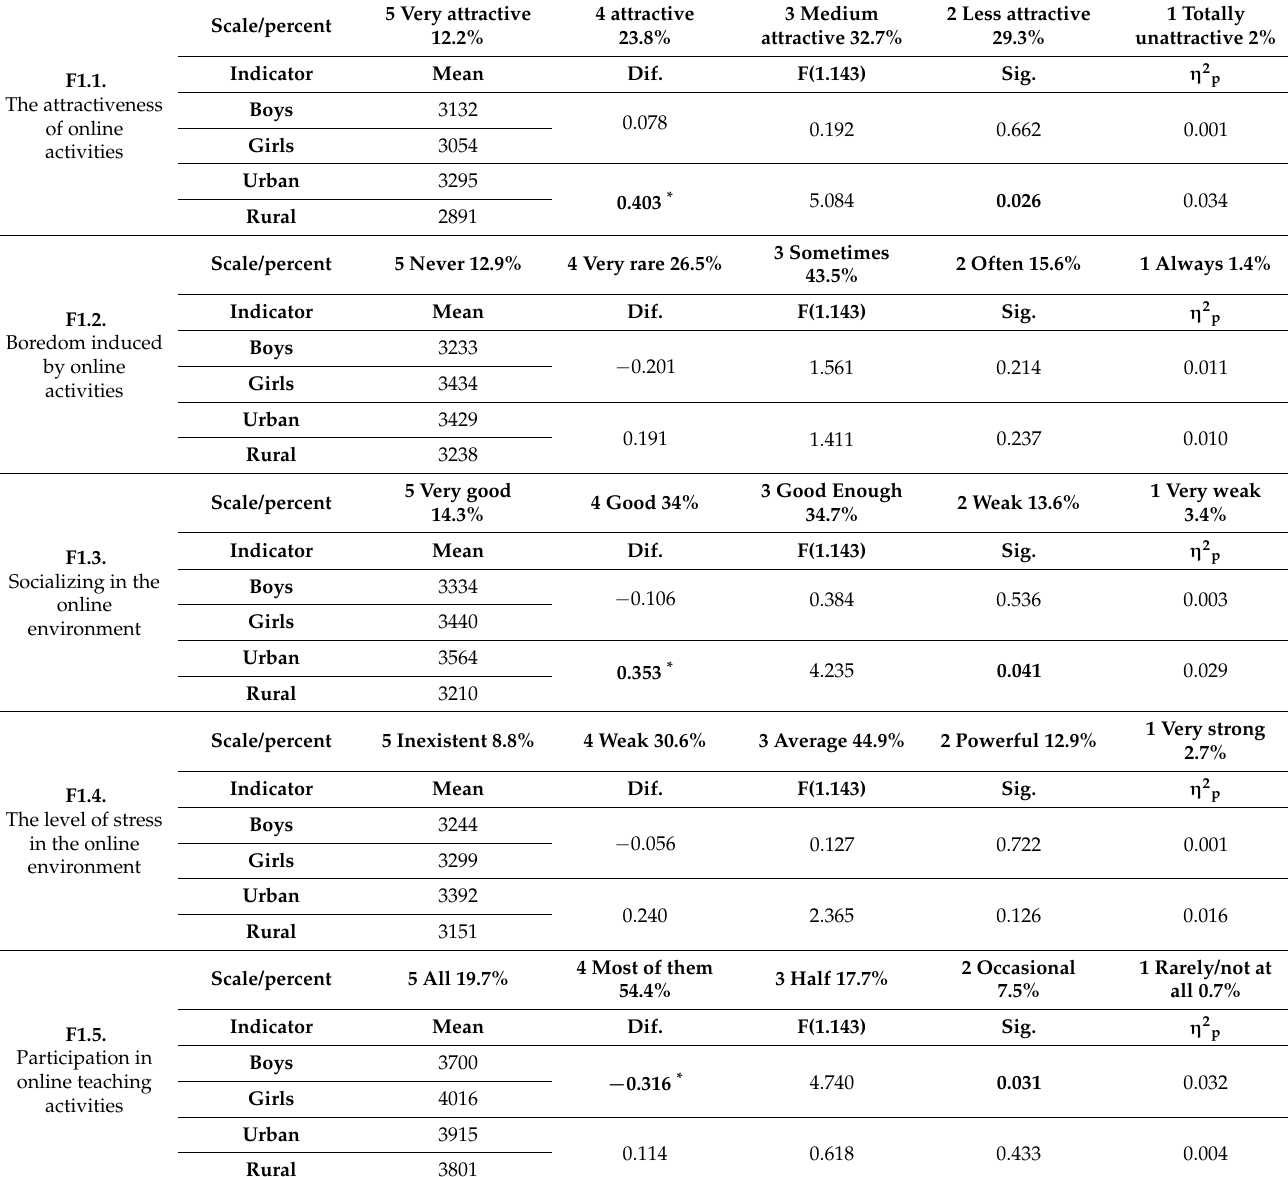
Table 4. The results of the questionnaire for the attractiveness factor (univariate